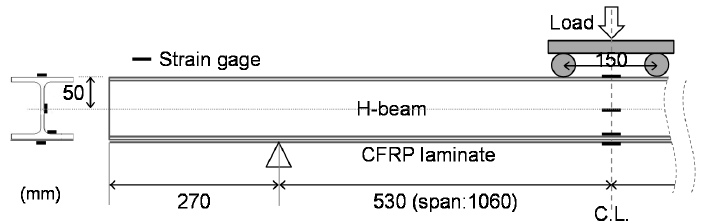
Figure 5. Schematic of the flexural test and instrumentation. C.L., Center Line.